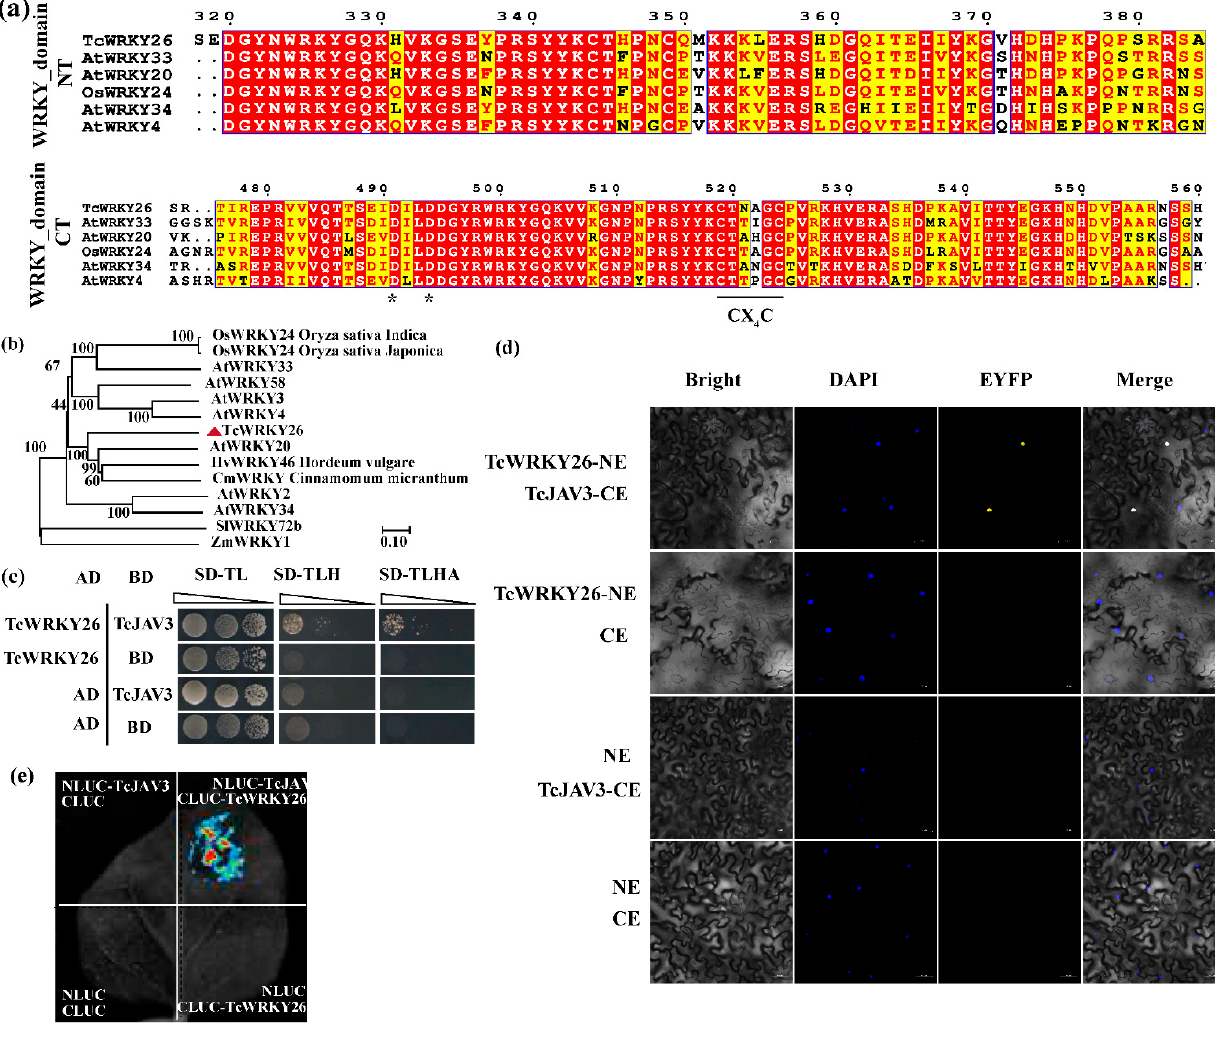
Figure 3. TcWRKY26, classical Group I WRKY, physically interacted with TcJAV3 ( a ) The two WRKY domains of TcWRKY26; only Group I WRKY factors have two WRKY domains. In the WRKY_domain_CT, the two D residues (labeled as *) and Cx 2 C motif are essential for the interaction with VQPs. ( b ) Phylogenetic tree of TcWRKY26 and reported Group I WRKYs. ( c ) Y2H results of TcWRKY26 and TcJAV3. SD/-TL: SD/-Trp-Leu; SD/-TLH: SD/-Trp-Leu-His; SD/-TLHA: SD/-Trp- Leu-His-Ade. ( d ) BiFC results of TcWRKY26 and TcJAV3. ( e ) LCI results of TcWRKY26 and TcJAV3. Bar = 50 µm.